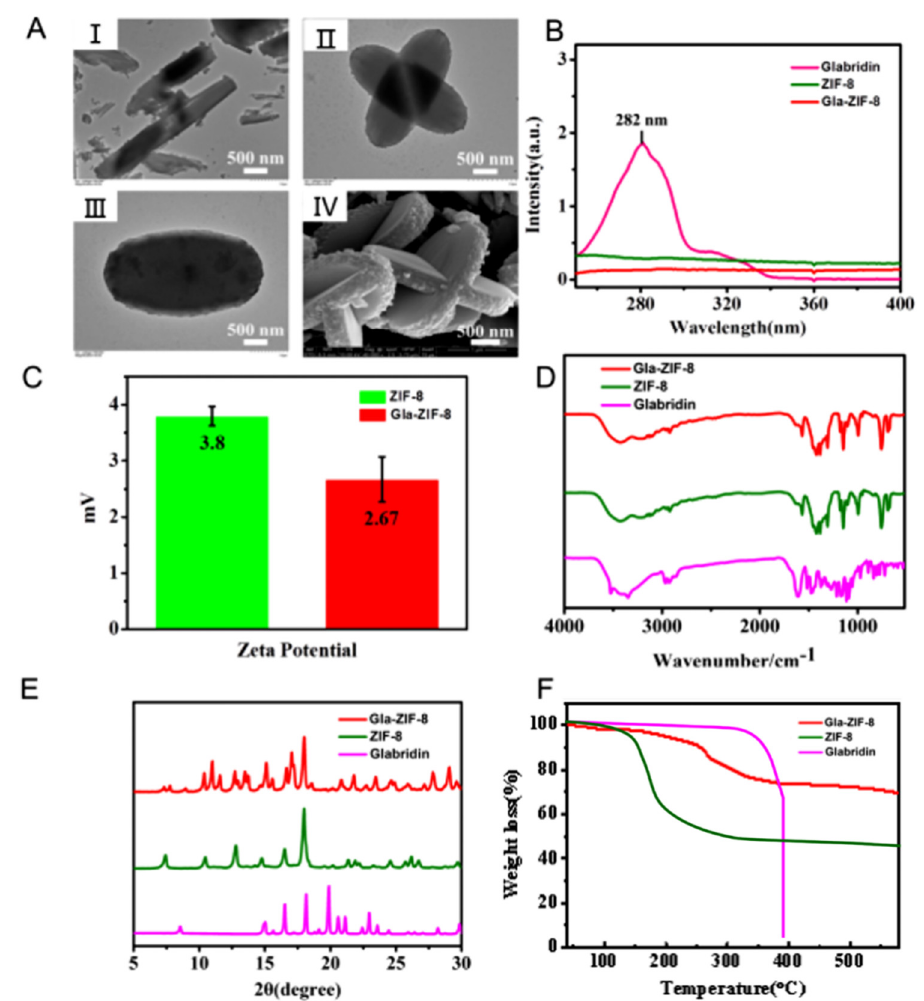
Figure 2. Physicochemical properties of Gla-ZIF-8. ( A ) TEM images of microcrystals of glabridin (I) and Gla-ZIF-8 (II, III) and an SEM image of Gla-ZIF-8 (IV). ( B ) UV-Vis spectra of glabridin, ZIF-8, and Gla-ZIF-8. ( C ) Zeta potentials of ZIF-8 and Gla-ZIF-8. ( D ) FTIR spectra of glabridin, ZIF-8, and Gla-ZIF-8. ( E ) XRD patterns of glabridin, ZIF-8, and Gla-ZIF-8. ( F ) TGA curves of glabridin, ZIF-8 and Gla-ZIF-8.